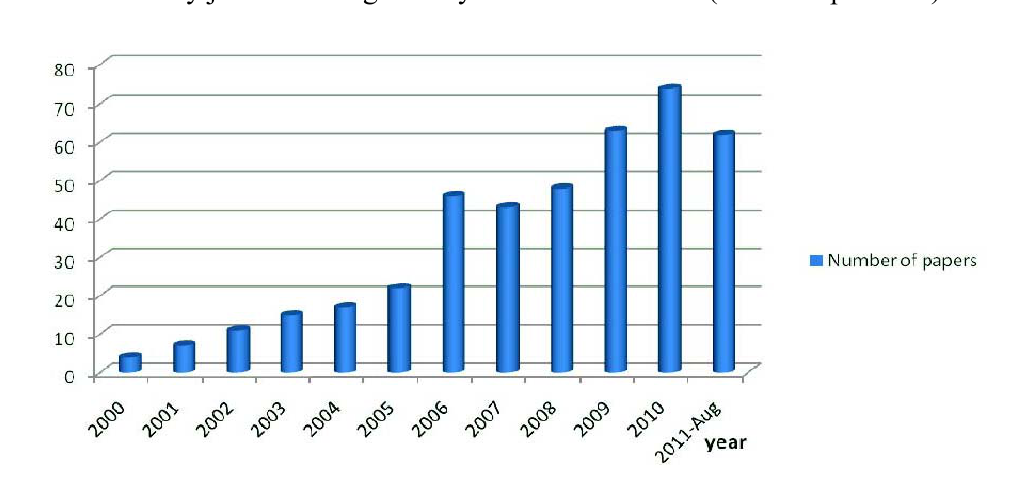
Figure 1. The number of papers published since the 2000th year (until August, 2011) in medicinal chemistry journals using the keyword “ microwave ”